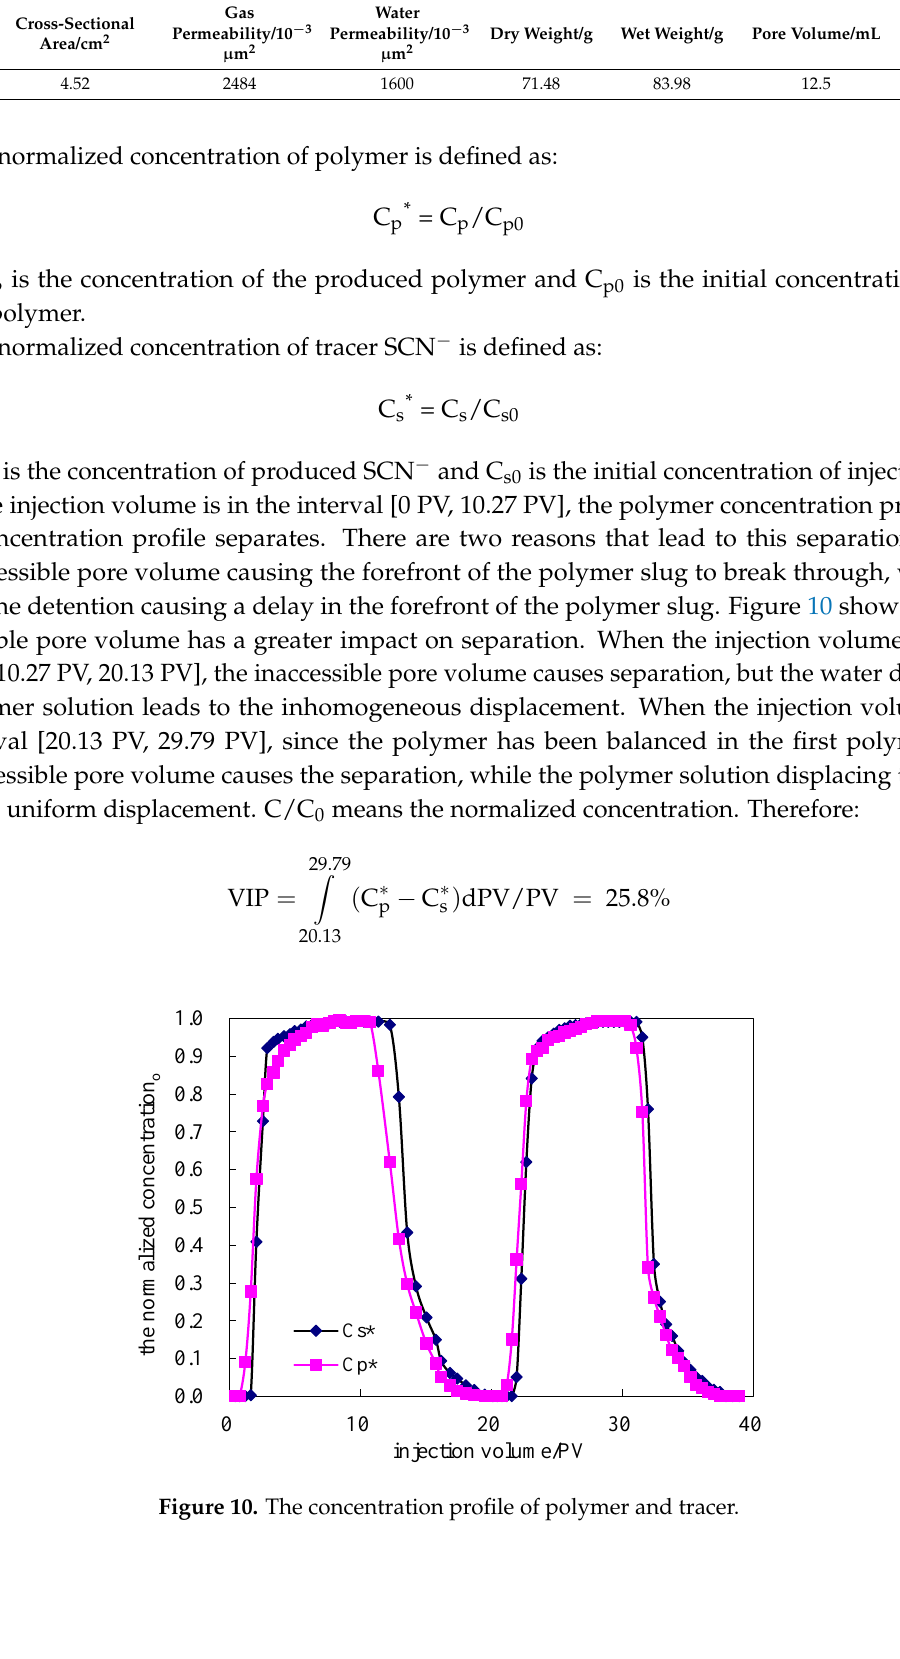
Table 6. The basic parameters of core.